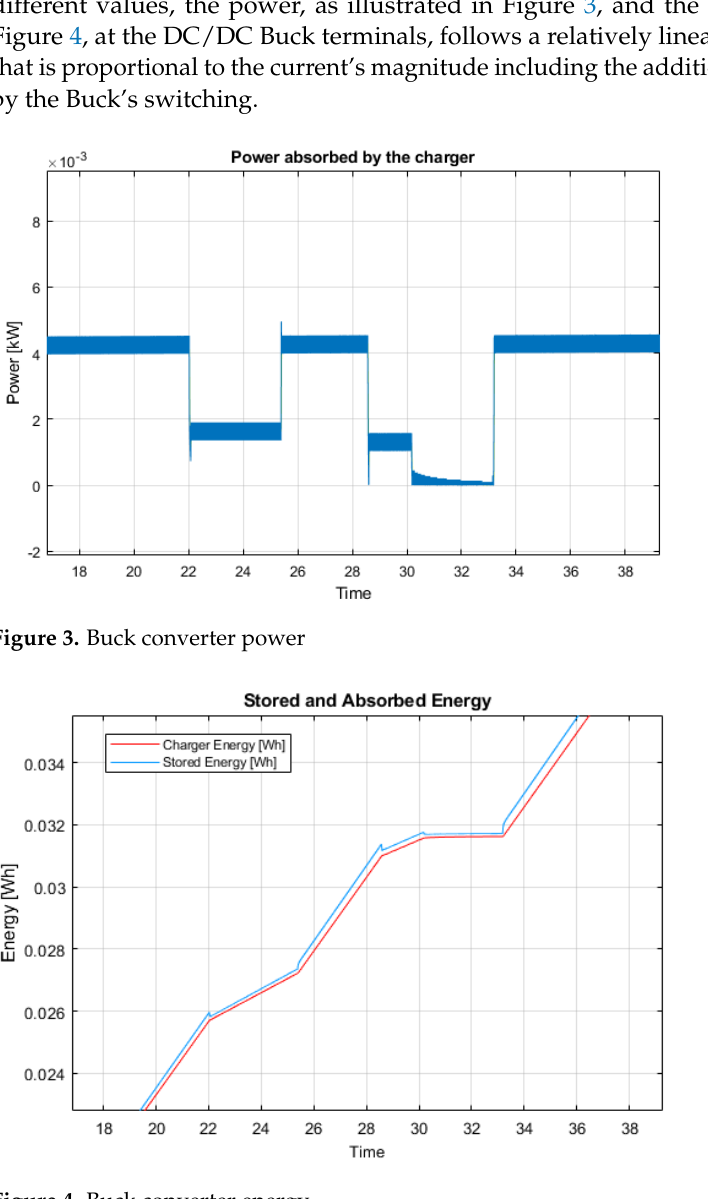
Figure 4. Buck converter